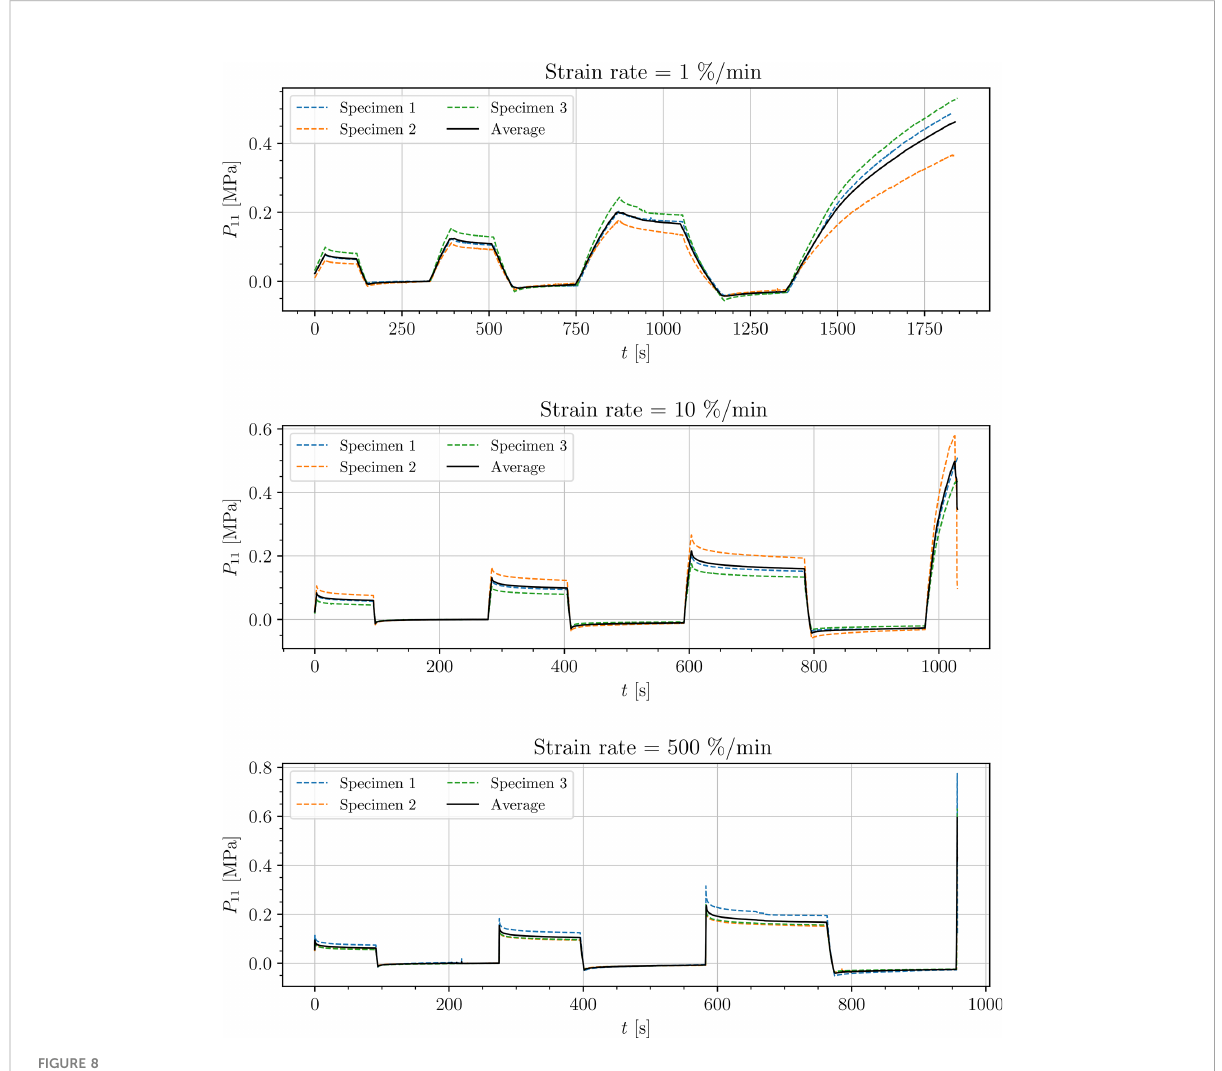
FIGURE 8 Uniaxial cyclic tensile stress-relaxation test of intercostal areas.